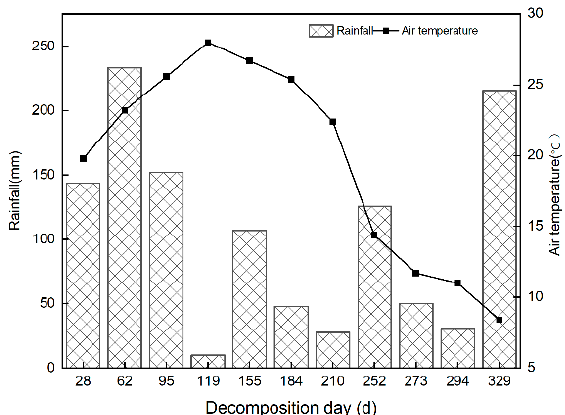
Figure 1. Dynamics of rainfall and temperature in the sampling site from April 2021 to February 2022. The numbers on the x-axis indicate the decomposition time in days after litterbag placement at each sampling time.